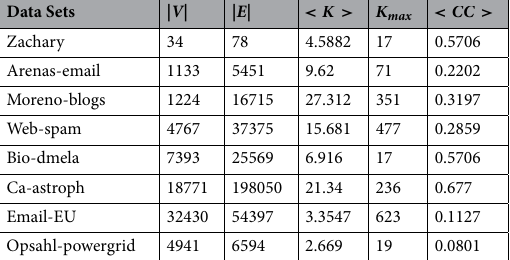
Table 3. The statistics of eight real-world complex networks: Node number | V |, edge number | E |, average degree < K > , maximum degree K max , and clustering coefficient < CC >